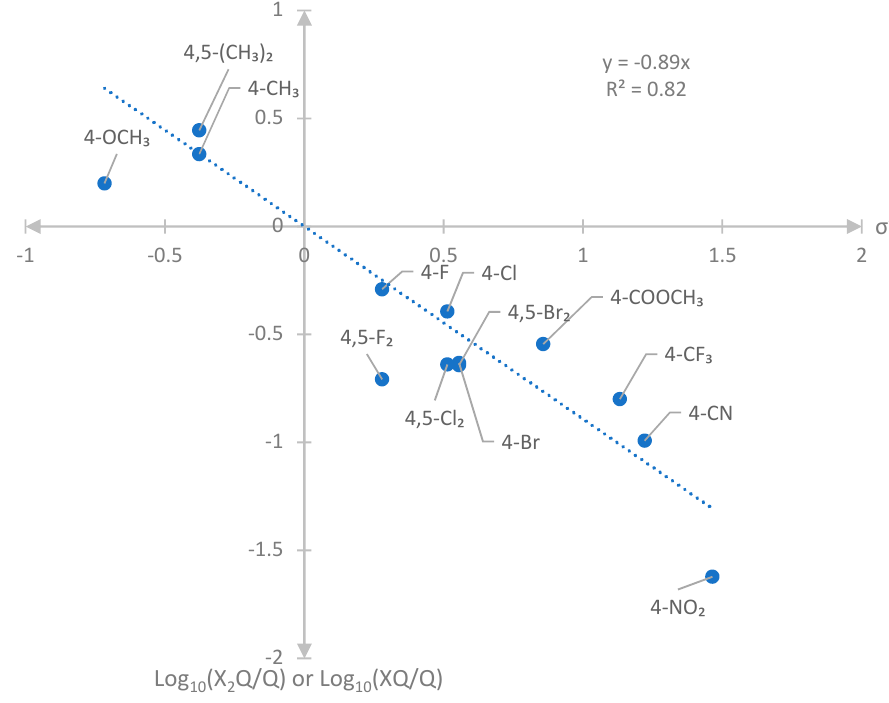
Figure 2. Hammett plot of XQ/Q or X 2 Q/Q ratio with standard composite σ + constants.